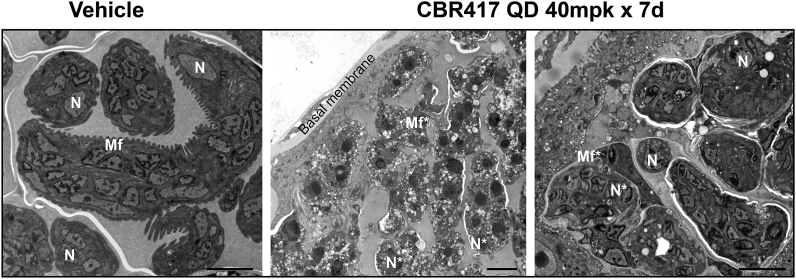
Transmission electron micrographs reveal extensive damage to the developing B. pahangi microfilariae in ovaries of worms from jirds treated with CBR417 QD 40 mg/kg for 7 days. N = nucleus; N* = abnormal nucleus; Mf = microfilariae developing in uteri; Mf* = abnormal microfilariae in uteri; bar = 4 μm.